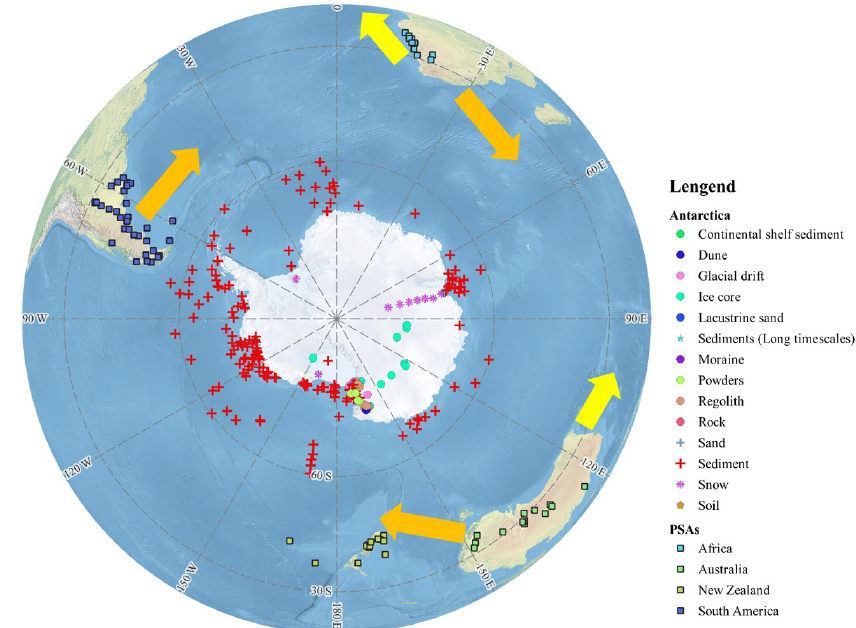
Figure 7. The locations of the samples for Sr–Nd isotope ratios from Antarctica and PSAs in this database. The dust transport paths are marked with yellow arrows, based on previous studies (Gaiero et al., 2007; Shao et al., 2011; Gili et al., 2022). (This figure was created with